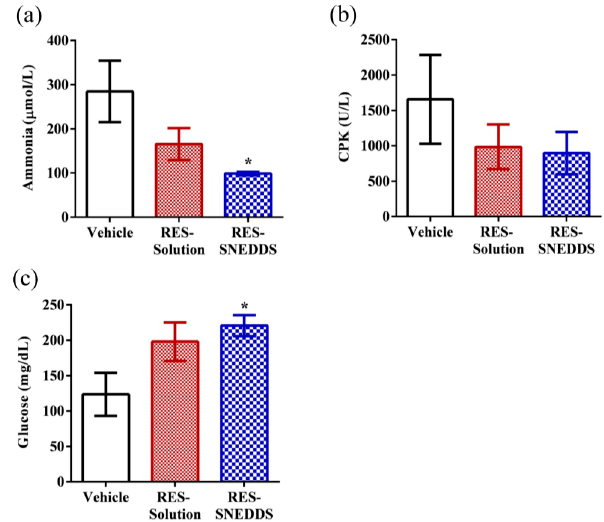
Figure 6. Effect of resveratrol (RES) on: serum ( a ) ammonia; ( b ) plasma creatinine phosphokinase (CPK); and ( c ) glucose levels, after swimming challenge. Data are expressed as mean ± standard error of the mean ( n = 5 for each group). * p < 0.05 compared with vehicle group.